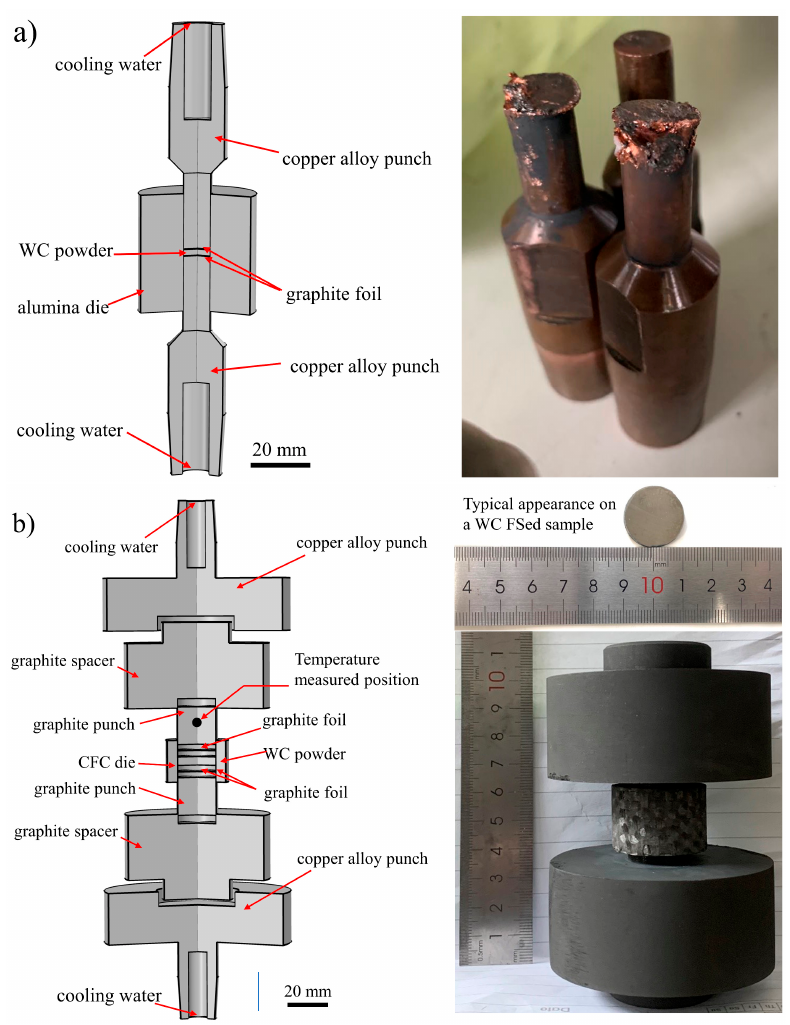
Figure 1. ( a ) Schematic representation of the alumina die and copper punches assembly commonly used in the ERS setup. The copper punches were damaged and the setup was unsuitable to consolidate binder-less WC. ( b ) Schematic and photograph of the newly developed experimental UFS set up with peak operating temperature well above 2500 °C. As shown in the inset, the samples were crack free. Table 1. Experimental parameters (current, time, average voltage) and obtained relative density. The recorded current for the second and third steps were 6 and 2.4 kA.